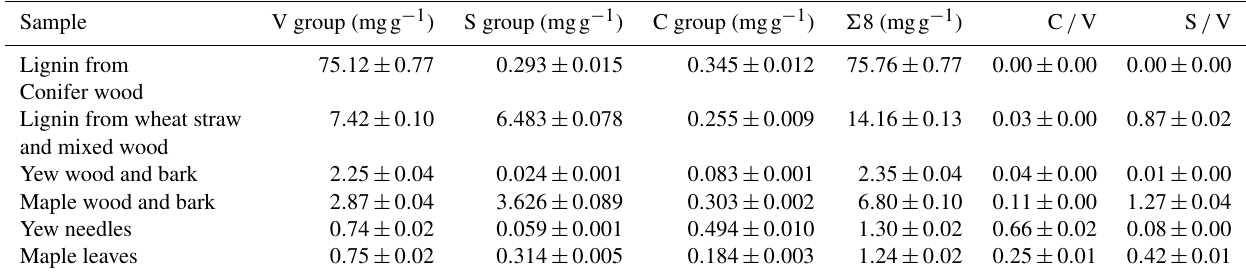
Table 3. Concentrations of the V-, S-, and C-group LOPs, the sum of all eight LOPs ( (cid:54) 8), and the ratios C / V and S / V in fresh plant and lignin